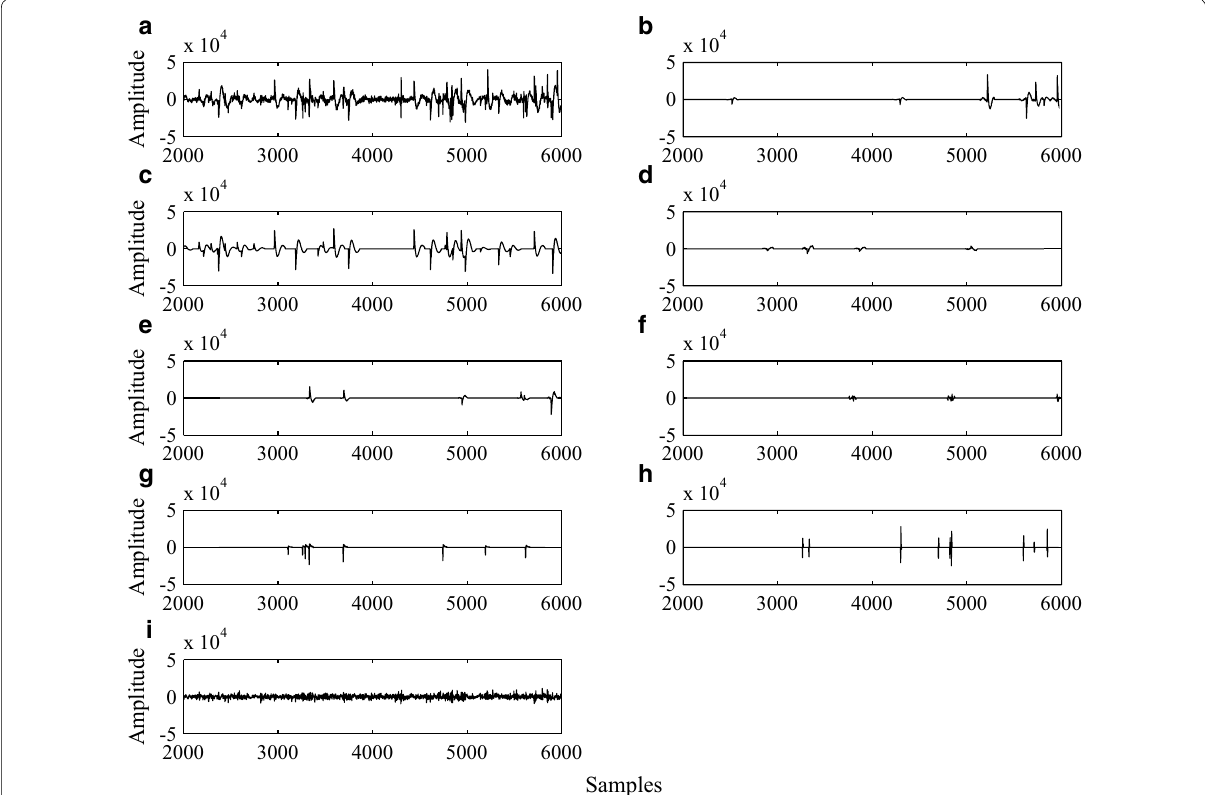
Fig. 11 Raw time-series segments ( a ), reconstructed components ( b – h ), and residual ( i ) of the Hx component from real site EL22192. Each component is reconstructed by a learned atom. The residual is obtained by subtracting all reconstructed components from the raw